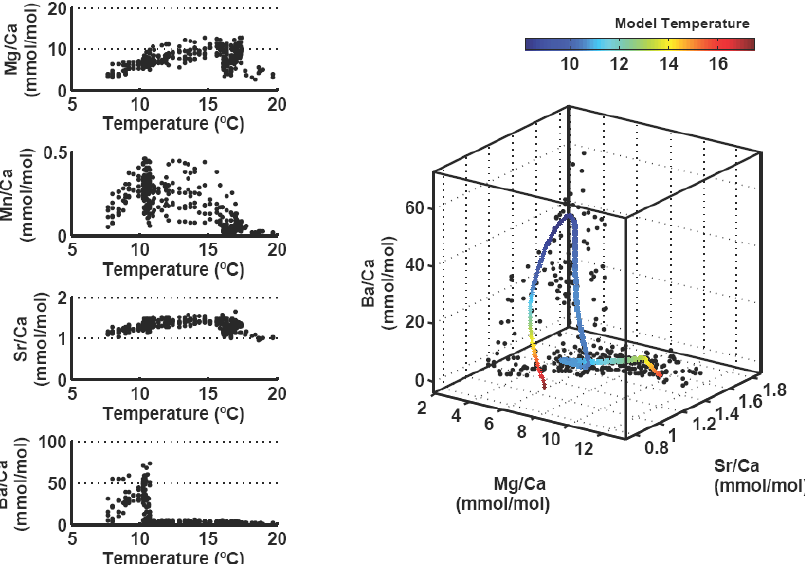
Fig. 2. Left: Ba/Ca, Sr/Ca, Mg/Ca and Pb/Ca ratios plotted against water temperature (Vander Putten et al., 2000). Right: Ba/Ca, Sr/Ca and Mg/Ca concentrations plotted against each other. The shown curve indicates how the concentrations are changing with water temperature (in colour).